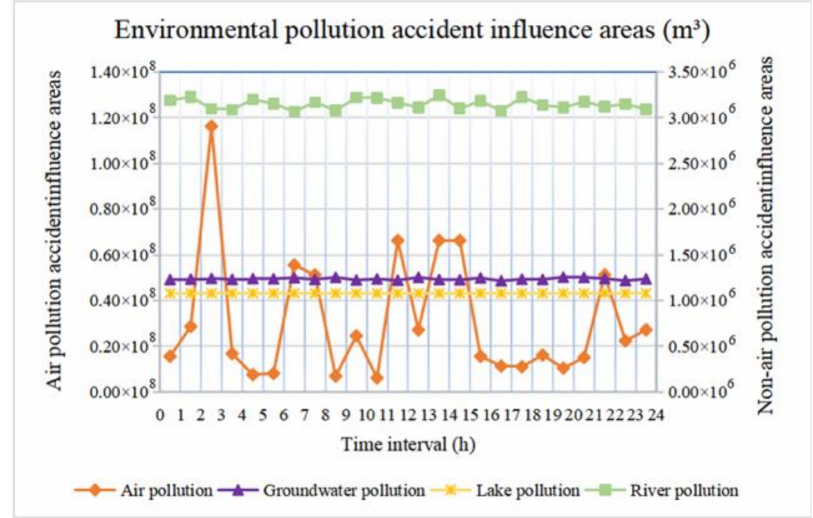
Figure 10. Environmental pollution accident influence areas.